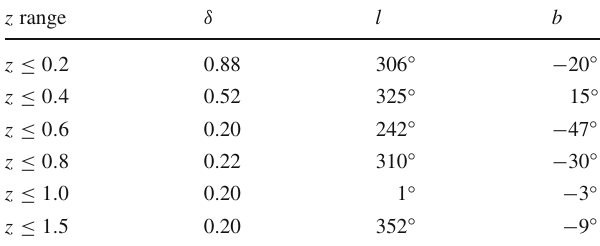
Table 6 Redshift tomography results using hemisphere comparison method for the Union2.1 data set